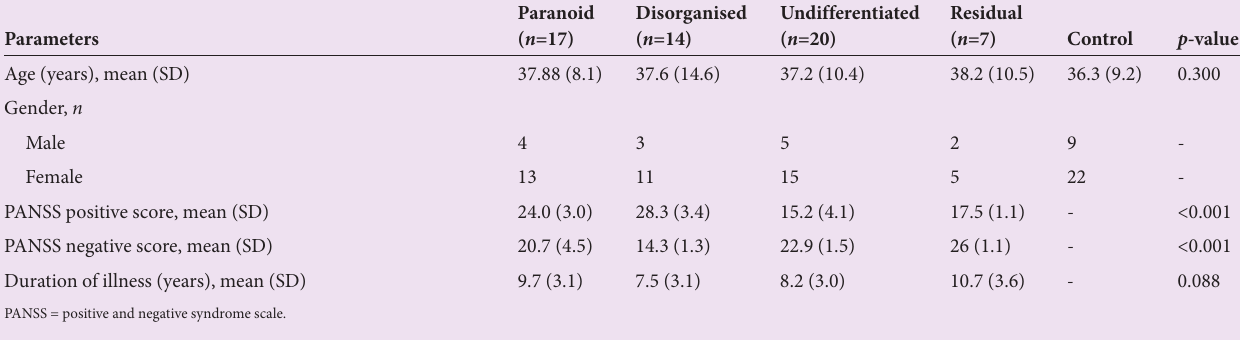
Table 1. Demographic and clinical characteristics of schizophrenia subtype patients and control subjects Parameters